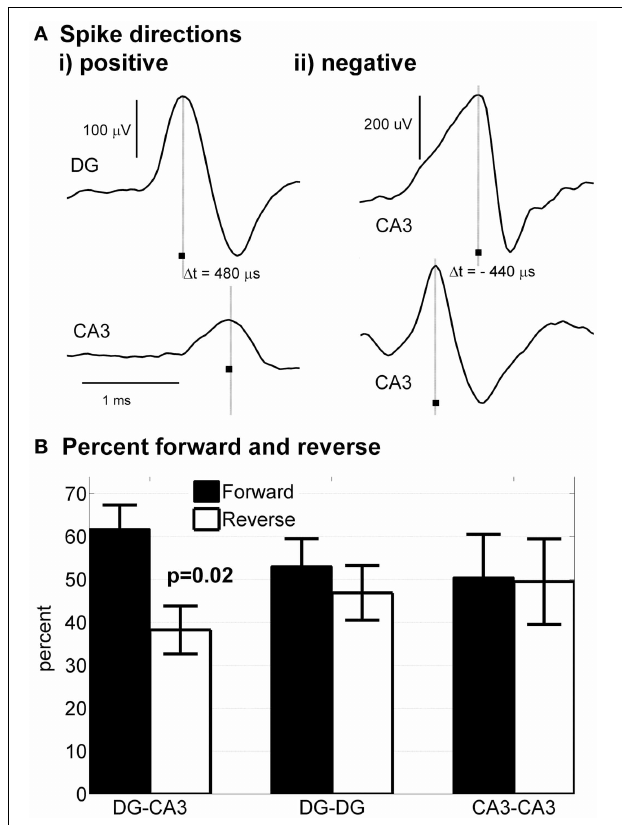
FIGURE 4 | Native polarity established from DG to CA3. Delay times of spikes traveling in axons in tunnels were determined from the difference in spike times at two tunnel electrodes separated by 200 µ m. (Ai) Example of spike travelling from DG to CA3 with a 480 µ s delay indicating a velocity of 0.42m/s. (ii) Example of spike propagation from the top to the bottom compartment (arbitrarily designated reverse direction for CA3-CA3). (B) Statistical analysis of directional propagation indicates 62% of tunnels spontaneously connect axons with anatomical accuracy from DG-CA3, while homologous regions across tunnels fail to show polarity (Wilcoxin non-parametric